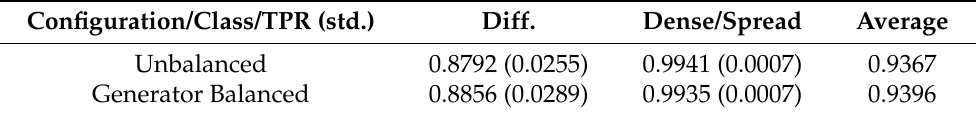
Table 10. Hierarchical tier 2: true positive rate for separation of dense/spread classes from differenti- ated. This tier serves to remove the mature cell colonies from the early and intermediate stage classes. The dense/spread classes have the highest level of misclassification, due to their relative proximity in terms of the downstream differentiation process, and subsequent similarity in texture features.